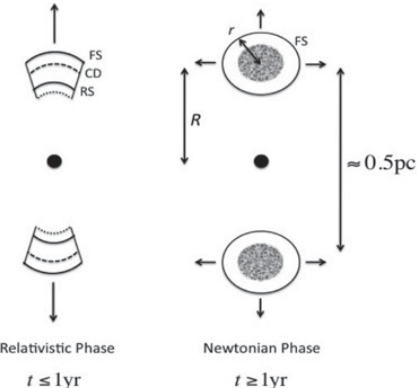
Figure 4. Sketch of the ultra-relativistic (left) and Newtonian (right) stages of jet deceleration. Initially, the jet propagates radially, forming a forward / reverse shock structure (Fig. 1), during which time the radio emission is relativistically beamed along the direction of the jet axis. Once the configuration has slowed to non-relativistic speeds, each of the two jet lobs expands quasi-spherically. For a typical o ff -axis viewer, emission peaks at the transition between the relativistic and non-relativistic stages (from